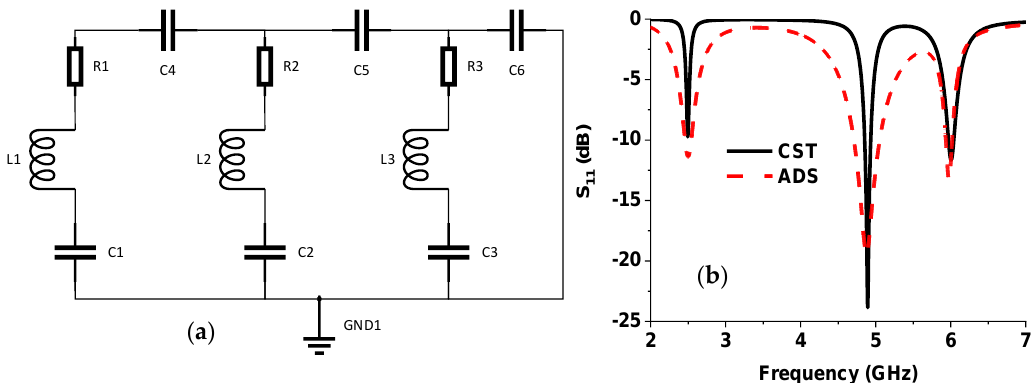
Figure 4. ( a ) Equivalent circuit diagram of the proposed MMA, L1 = 27 nH, L2 = 13.62 nH, 19.5 nH, C1 = 0.15 pF, C2 = 0.078 pF, C3 = 0.054 pF, C4 = 40.57 pF, C5 = 0.06 pF, C6 = 0.05 pF, R1 = 28.5 ohm, R2 = 40.5 ohm, and R3 = 23.5-ohm ( b ) S11 curve from CST and ADS. Coupling capacitances C4, C5, and C6 are calculated by Equation (5), where conducting strip area is A , the distance between the two strips is d , and ε r ε 0 are the relative permittivity and free space permittivity.